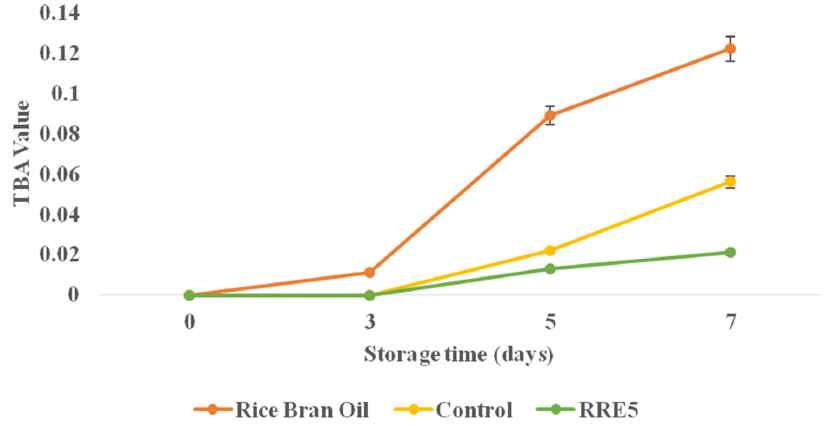
Figure 7. Effect of storage period (7 days) on TBA value of rice bran oil, control, and RRE5 nanoemulsion. Data are presented as means ± SD ( n = 3).